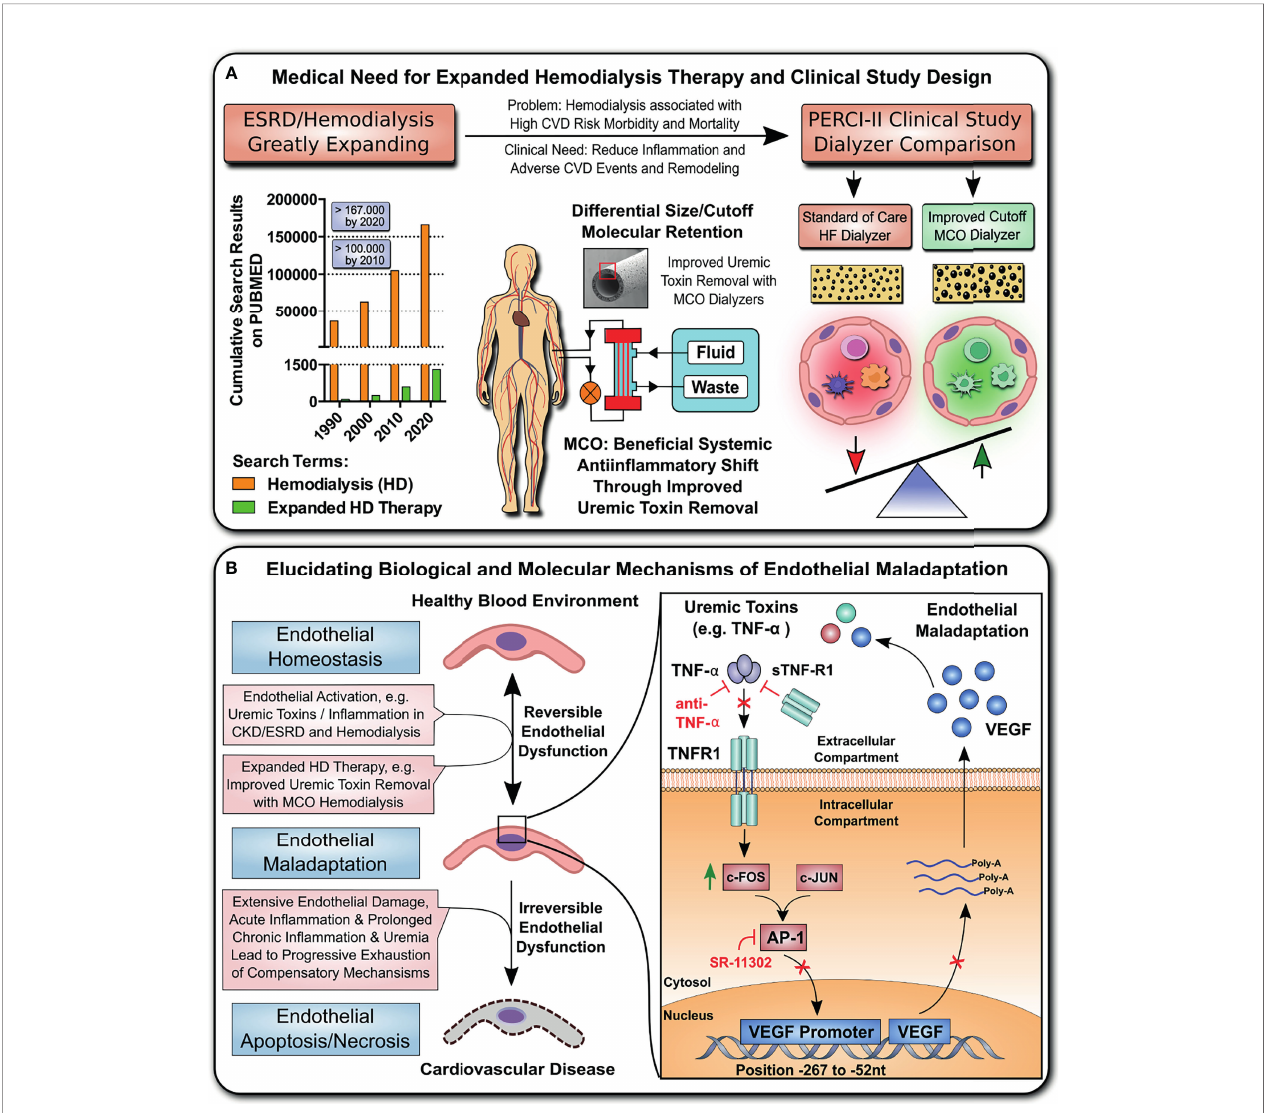
FIGURE 1 | Study design and hypothesis: Expanded Hemodialysis Therapy ameliorates systemic In fl ammation and endothelial maladaptation and dysfunction. (A) The medical need for Expanded Hemodialysis Therapy and clinical study design: The hemodialysis fi eld has been shown a near exponential growth in the past decades, with >167.000 publications on PUBMED containing the search-term “ Hemodialysis ” in 2020. Recently, particular attention has been placed into lowering chronic treatment-associated adverse cardiovascular diseases (CVD) and new optimized treatment concepts, such as “ Expanded Hemodialysis Therapy ” with improved molecular cut-off hemodialyzers (8, 27). Within the PERCI-II study n=48 hemodialysis patients underwent crossover randomized multi-center comparison employing novel medium-cut-off (MCO; MCOI-Ci400, Gambro) dialyzers in comparison to standard of care high- fl ux (HF) hemodialyzers (PERCI-II-MCO; ClinicalTrials.gov: NCT02084381) (28). These novel MCO dialyzers have an improved molecular size cut-off, which positively modulates systemic microin fl ammation (28). (B) Goal of the follow up study: To Elucidate the Molecular and Biological Mechanisms: In the present study, we explore the molecular signaling mechanisms underlying this positive antiin fl ammatory shift and evaluate promising leads identi fi ed during the fi rst screen in 2017. In particular, we study the modulation of TNF- superfamily members in sera of patients undergoing MCO dialysis and how this impacts on uremia- and TNF- a -induced endothelial maladaptation and dysfunction (left panel) and the molecular mechanisms (right panel), resulting in aberrant VEGF induction and angiogenesis. Our VEGF promoter activation studies and adjunct signaling pathway experiments elucidated that this detrimental uremia- and TNF- a -induced signaling is mediated via AP-1/c-FOS signaling and that alterations in the serum ratio between TNF- a and sTNF-R1, but not sTNF-R2, are potential indicators for endothelial maladaptation. These fi ndings provide new avenues for molecular targets and treatment modalities to reduce chronic microin fl ammation in the context of